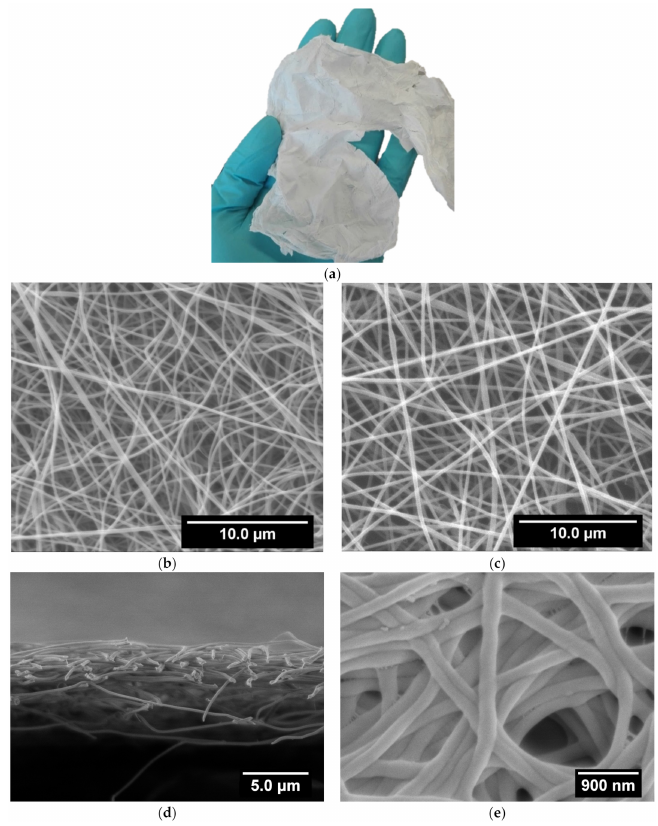
Figure 1. ( a ) Photography of the macroscopic aspect of the curdlan–chitosan scaffold as removed from the collector and SEM images of ( b ) electrospun chitosan membrane (Acceleration Voltage (AV) 20 keV), ( c ) electrospun curdlan–chitosan membrane (AV 20 keV), ( d ) cross section of electro- spun curdlan–chitosan membrane (AV 3 keV), ( e ) electrospun curdlan–chitosan membrane after stabilization (AV 3